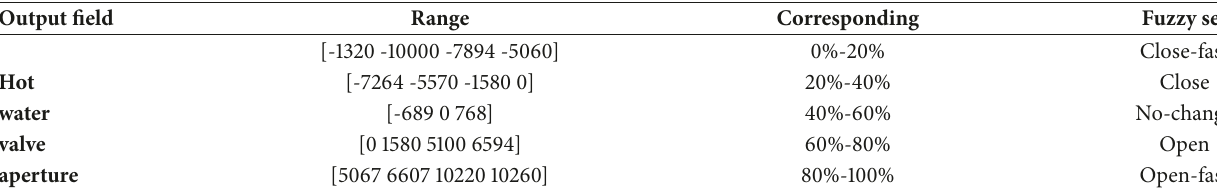
Table 8: MFs of first output.